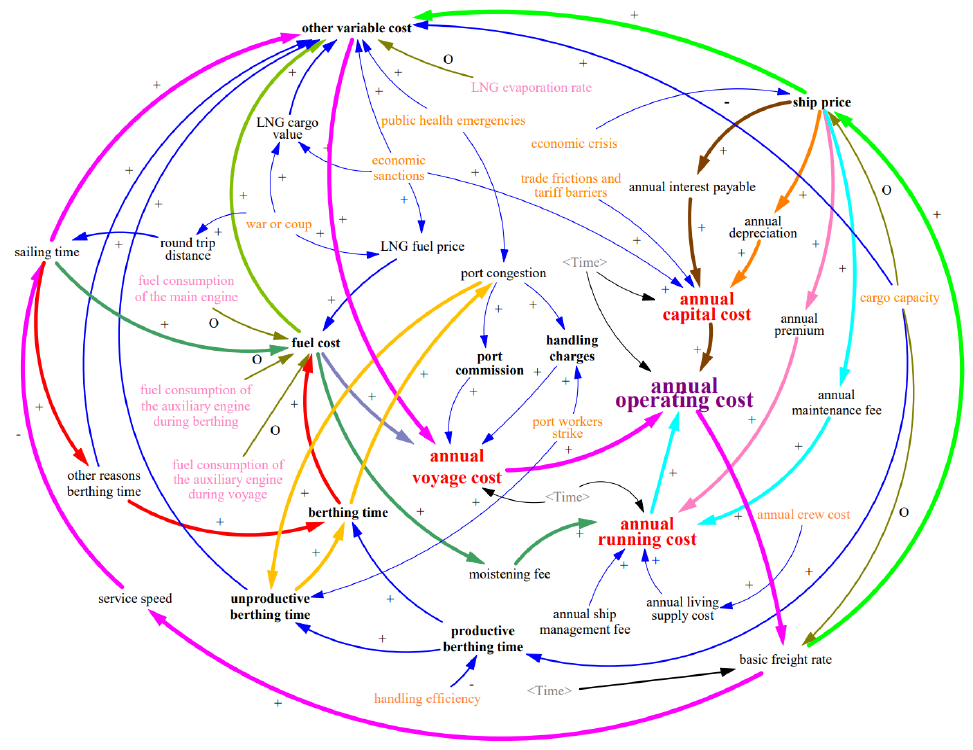
Figure 2. System dynamics feedback loop diagram.